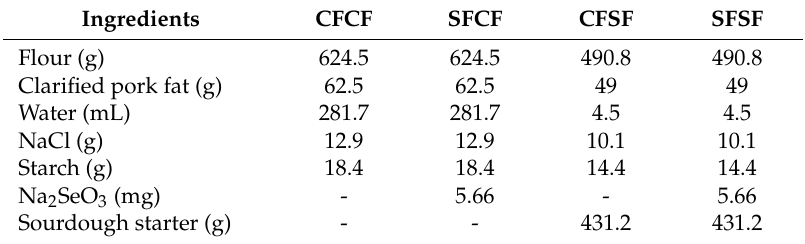
Table 1. Piadina recipes. CFCF: Control flour and conventional fermentation; SFCF: Se-enriched flour and conventional fermentation; CFSF: Control flour and sourdough fermentation; SFSF: Se-enriched flour and sourdough